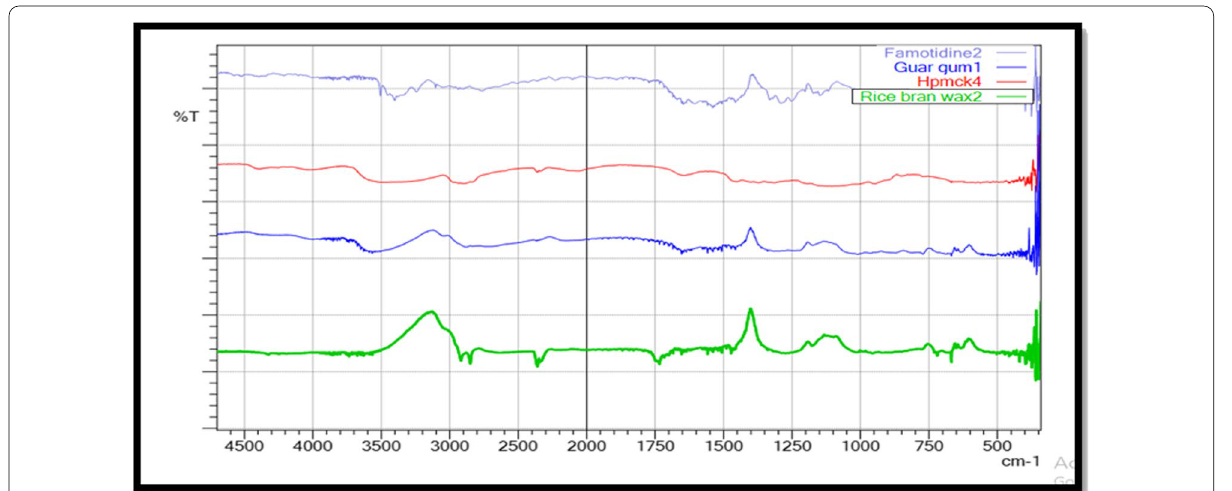
Fig. 1 Overlay spectrum of physical mixture of drug, polymer and gum